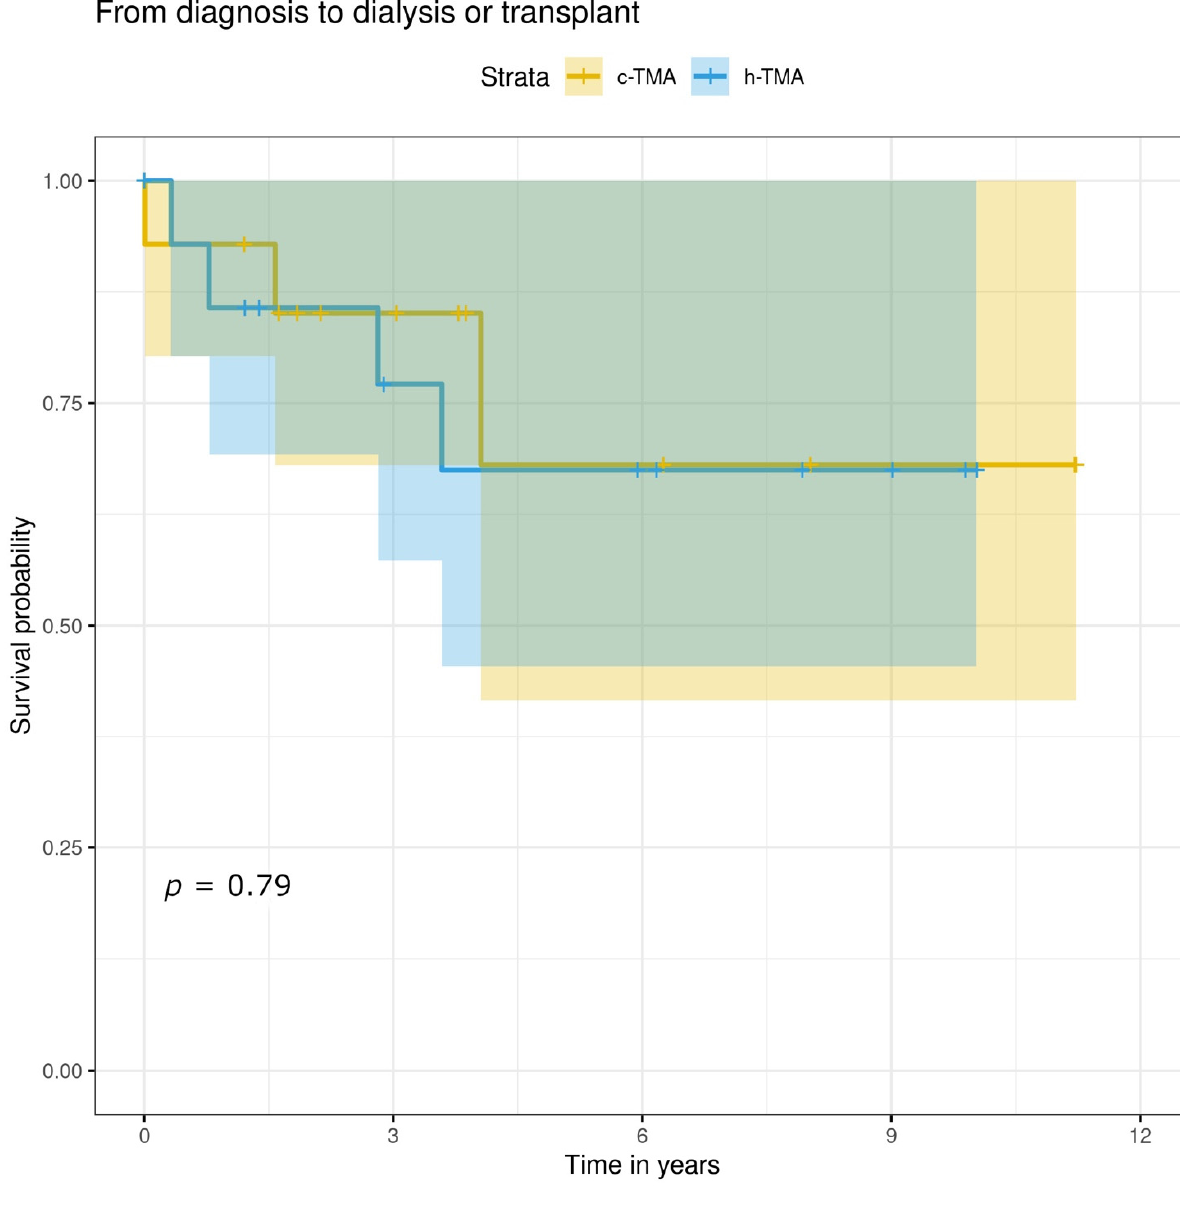
Figure 3. Kaplan–Meier curve on kidney failure from diagnosis resulting in dialysis or transplantation with c-TMA and h-TMA patients.